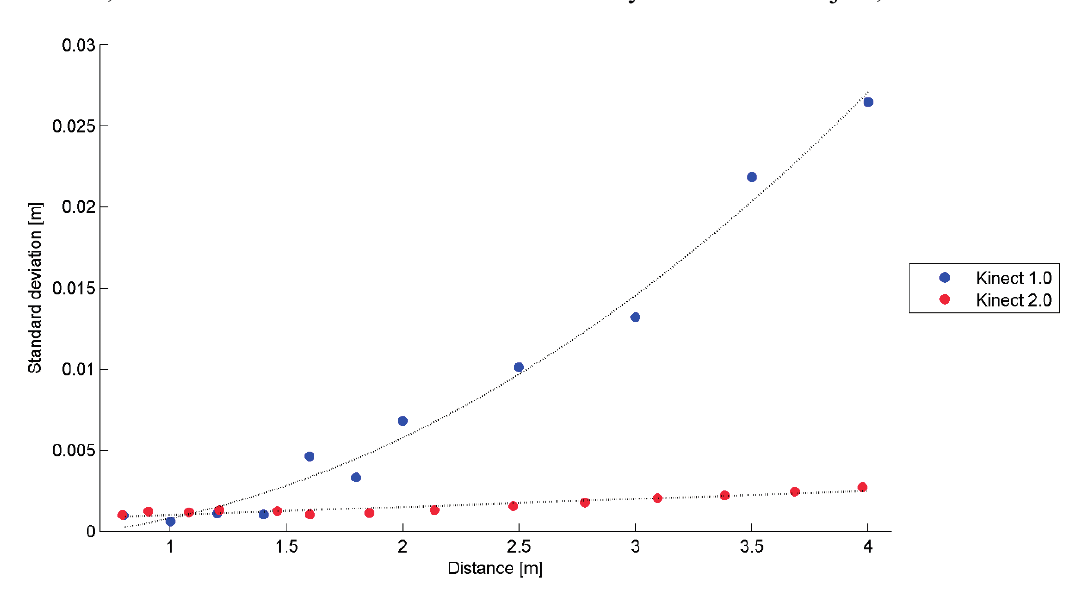
Figure 10. Standard deviation of the depth measurement performed by the two Kinect sensors as a function of the measured